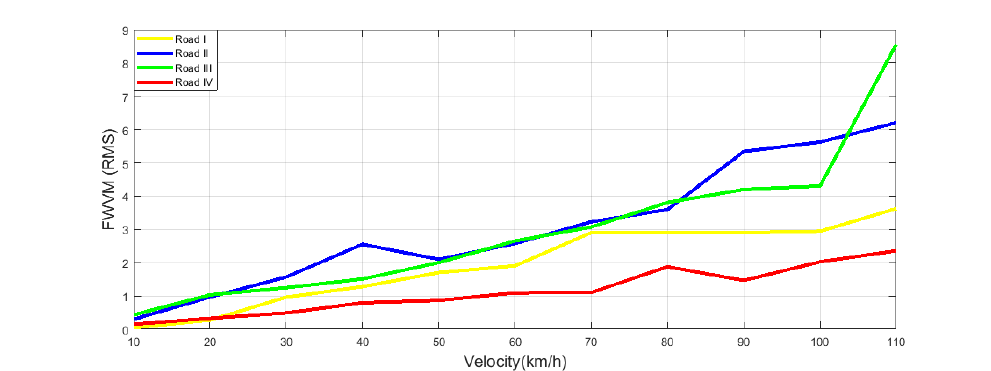
Figure 5. FWVM values of road profiles at different velocities.